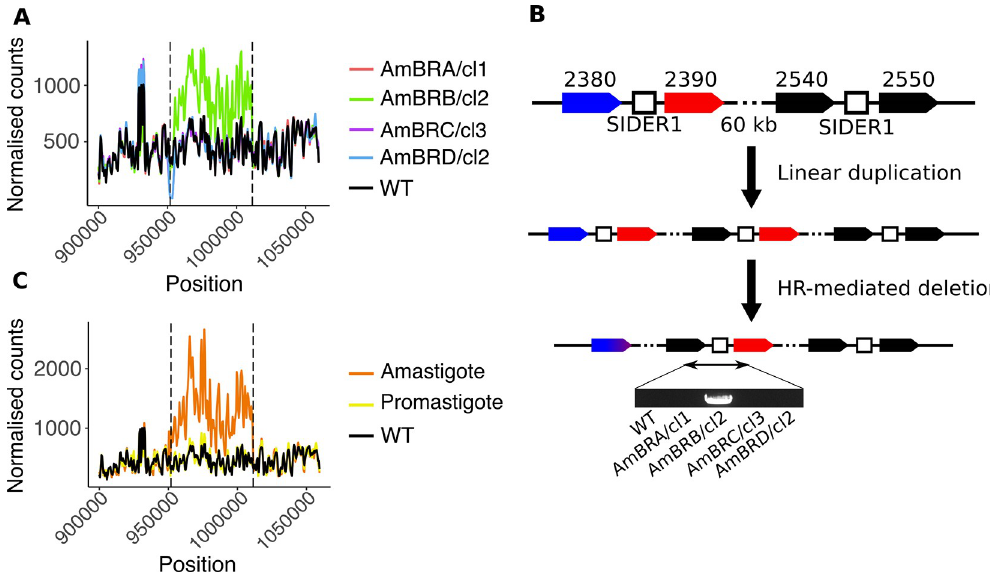
Fig 6. Structural changes associated with SIDER1-mediated amplification. A) Genome coverage of the region around the SMT locus. Normalised mapped read count for 500 bp windows is plotted against genomic position on chromosome 20 (normalisation was achieved by adjusting counts by the ratio between total mapped read counts for chromosome 20 for that line compared to wild-type). Vertical dotted black lines denote the mid-point position of the two tandem SIDER1 elements. B) A model for structural changes in AmBRB/cl2. Initial SIDER1-mediated linear duplication of a ~60 kb region is followed by homologous recombination-mediated deletion as depicted in Fig 5D. Note that whether these steps happen sequentially or simultaneously cannot be determined. Amplification leads to proximity between LmxM . 36 . 2540 and an SMT gene copy, which is only detectable by PCR in AmBRB/cl2, as shown here (for full gel image see S10 Fig). C) Genome coverage of the region around the SMT locus in a previously selected AmB-resistant amastigote line. See panel (A) for details. Coverage data for a promastigote line derived from the same parent that did not exhibit amplification, as well as the wild-type line used in this study, are included for